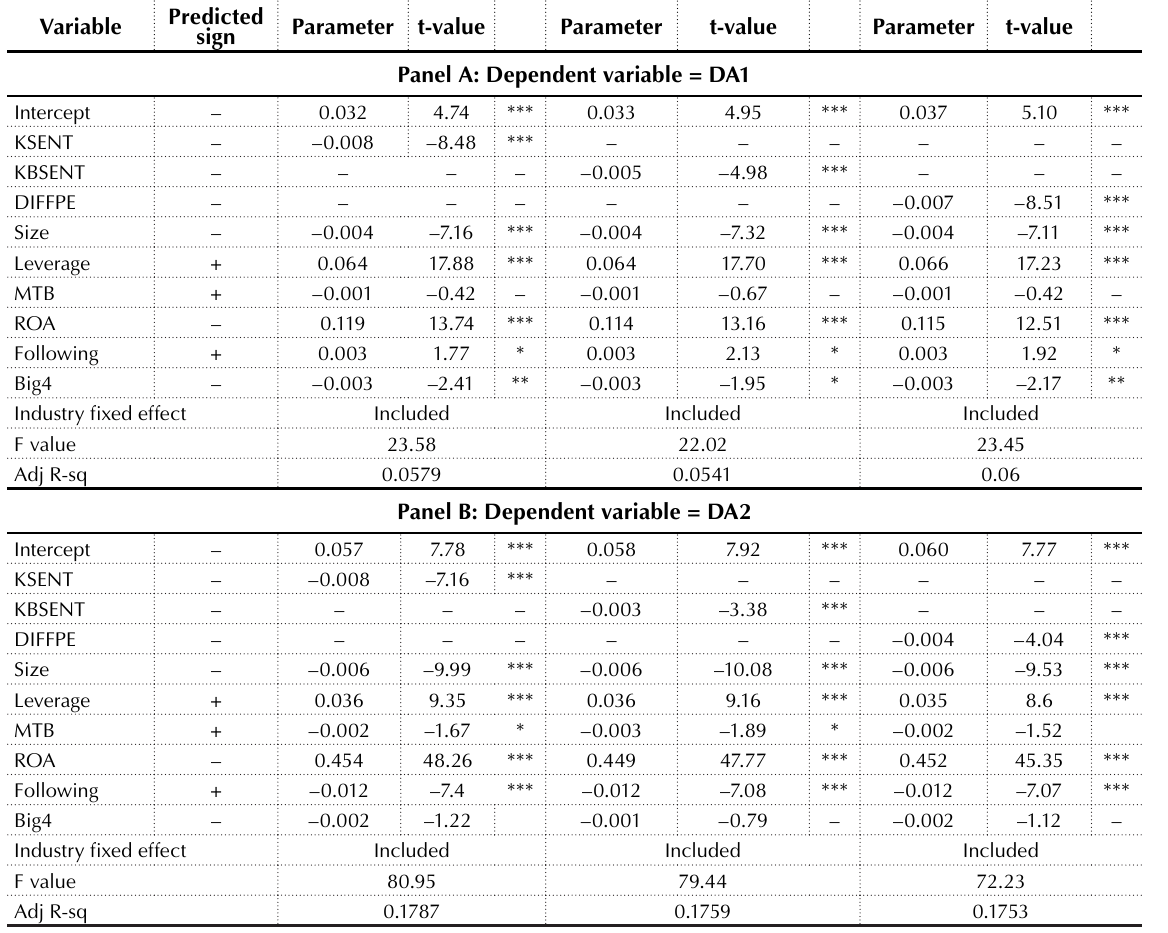
Table 3. Investor sentiment and discretionary